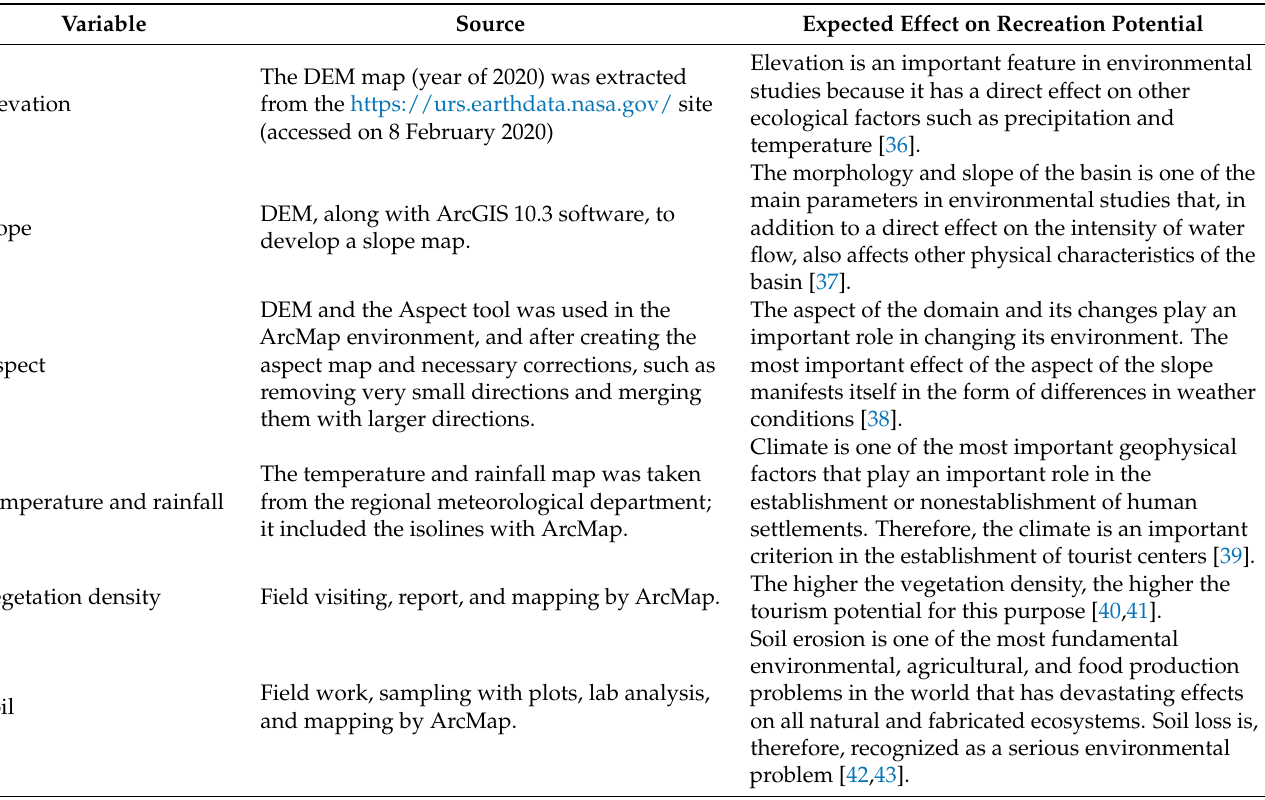
Table 1. Ecological factors used to evaluate outdoor recreation